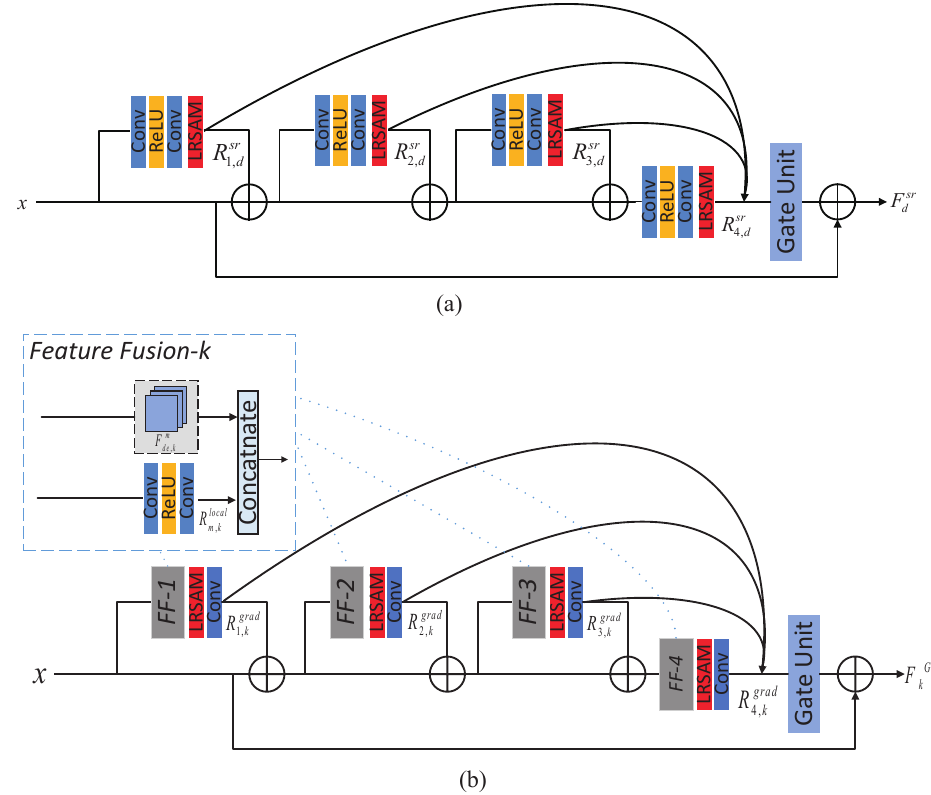
Figure 5. Two kinds of residual space attention adaptive aggregation module architectures (i.e., RS3AM-SR and RS3AM-G). ( a ) Architecture of the d-th RS3AM-SR that acts on the SR branch. ( b ) Architecture of the k-th RS3AM-G that acts on the gradient branch. For convenience, we only show the architectures of these two models separately when M =